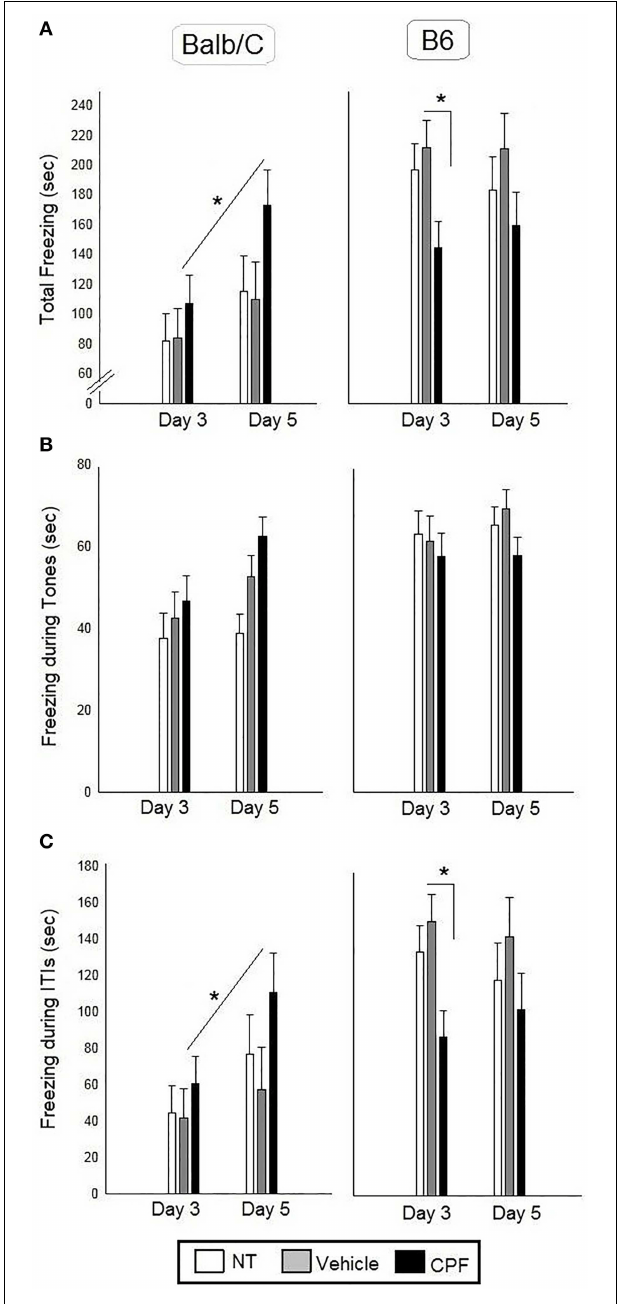
FIGURE 3 | Fear conditioning in adult Balb/C and B6 mice. (A) Mean ( ± SEM) of freezing on Day 3 and on Day 5 [during the 4 tones and the 4 inter-tone intervals (ITIs)]. (B) Mean ( ± SEM) of freezing during the tones. (C) Mean ( ± SEM) of freezing during the ITIs. * p < 0 . 05 CPF vs. Vehicle in Balb/C. For clarity, effects not related to CPF treatment are not marked on the graph and are described in Section Pavlovian Fear Conditioning. Balb/C: NT-N = 9; Vehicle-N = 7, CPF-N = 9 B6: NT-N = 9; Vehicle-N = 8, CPF-N =